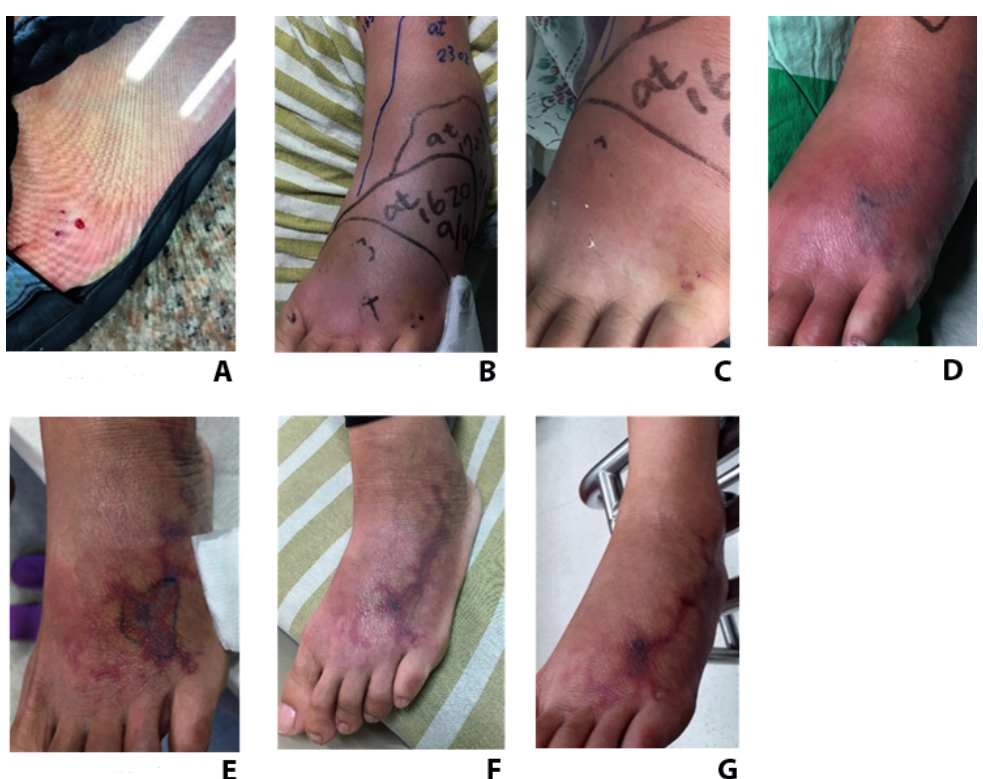
Figure 1. The evolution of a wound that did not undergo debridement. (A) A 46-year-old woman was bitten by a cobra on the left 5 th toe, presenting pain and foot swelling. (B, C) After six hours, red to violaceous reticular patches with some central necrotic tissue were present. (D, E) Progressive limb swelling with